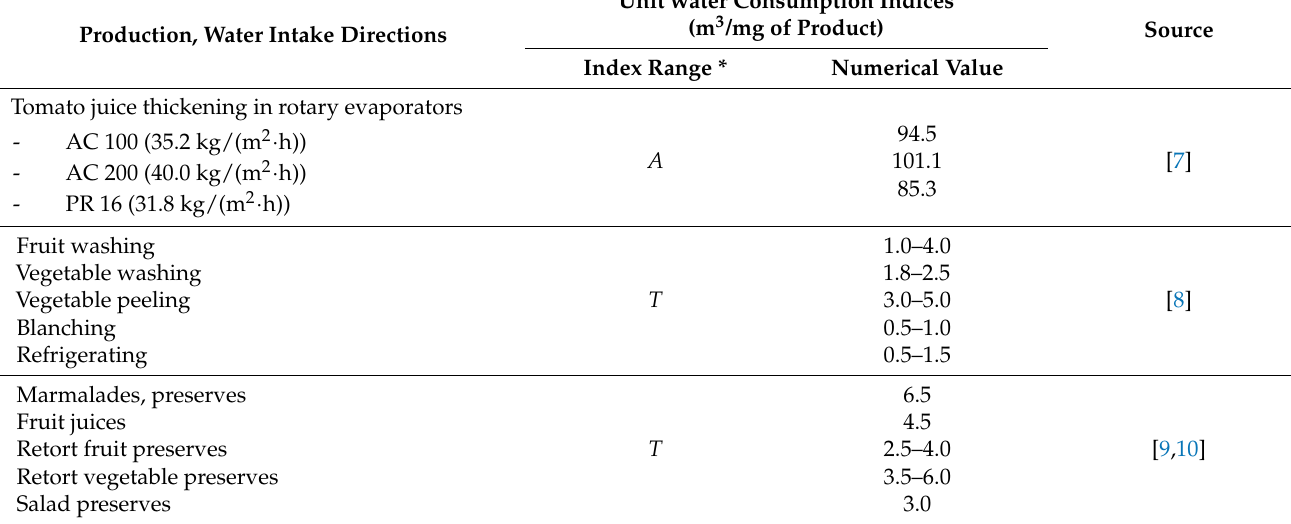
Table 1. Water consumption index per product unit in fruit and vegetable industry